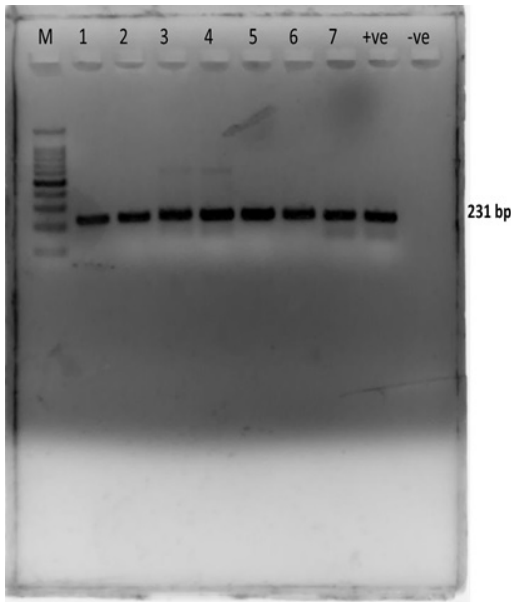
Figure 3. Genotypic confirmation of E. coli from endometritis samples. M = marker 1000 bp, wells 1–7 Sample at 231 bp, +ve = positive control, − ve = negative control.